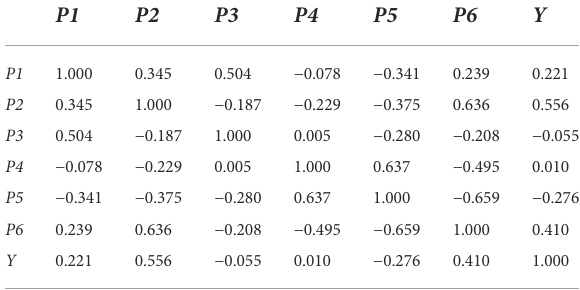
TABLE 5 The correlation coef fi cients between the individual chromatographic peak area and between the peak area and the comprehensive evaluation value of